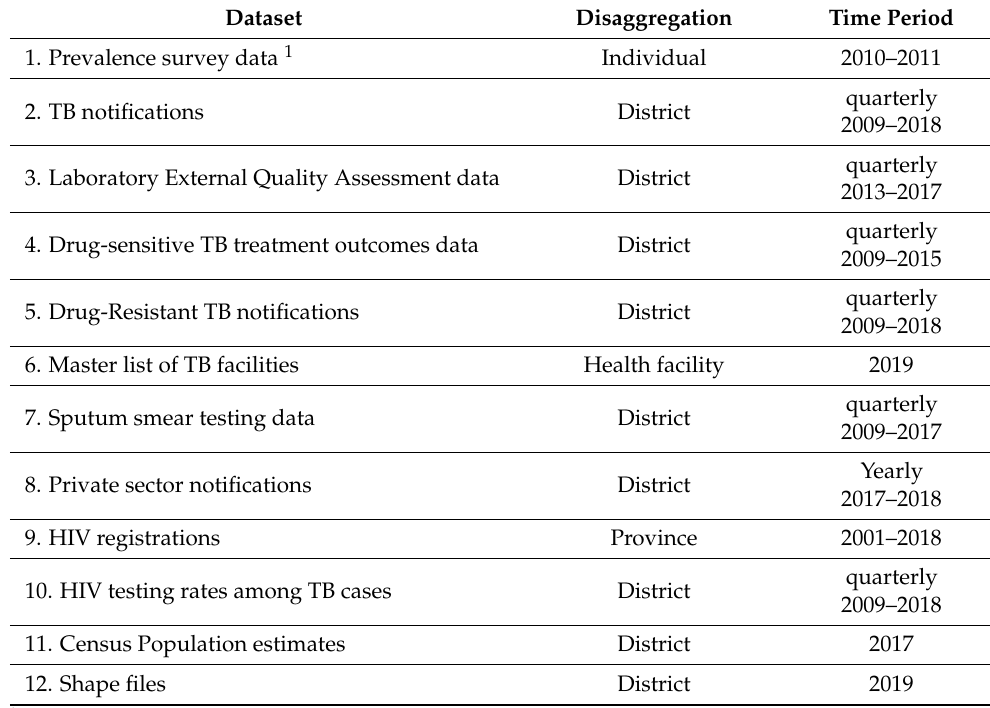
Table 1. Datasets made available to TB hackathon modelers by Pakistan NTP.